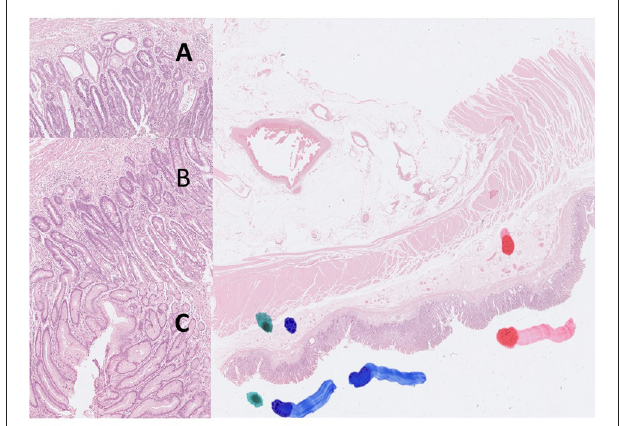
FIGURE 3 | Digital pictures of H&E stain created by Hamamatsu Nanozoomer S360 scanner and QuPath software (40X). The color markers were made by a pathologist to localize the targeted areas (green color: gastritis; blue color: intestinal metaplasia; red color: gastric adenocarcinoma). (A) adenocarcinoma, (B) intestinal metaplasia, (C) gastritis.